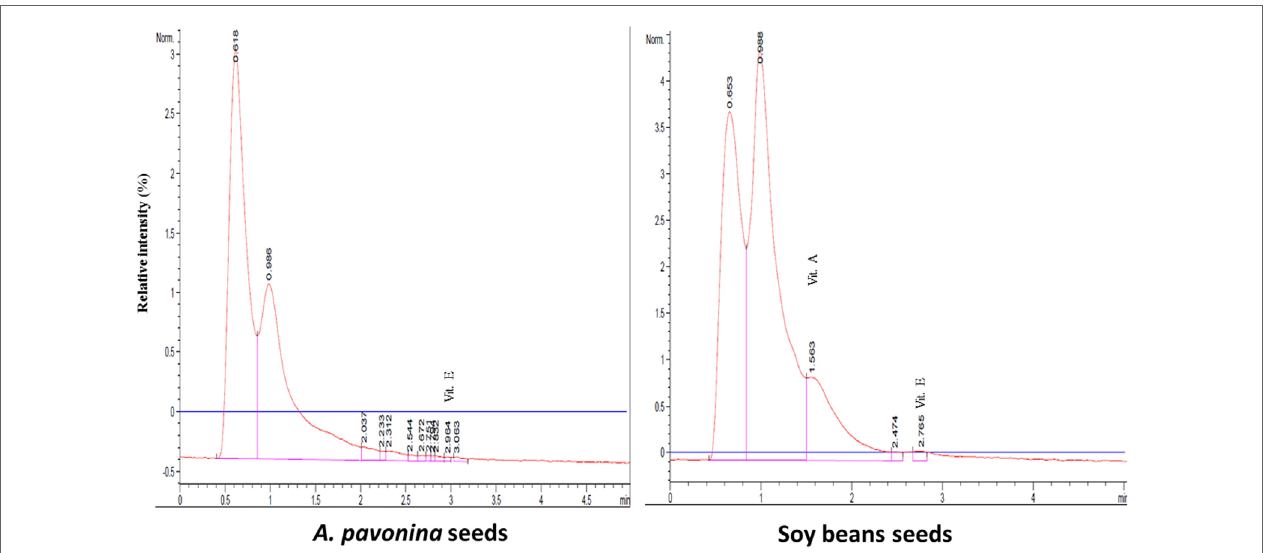
FigUre 1 | Chromatogram for the three fat-soluble vitamins in pro-milk extracted from A. pavonina and soy bean.